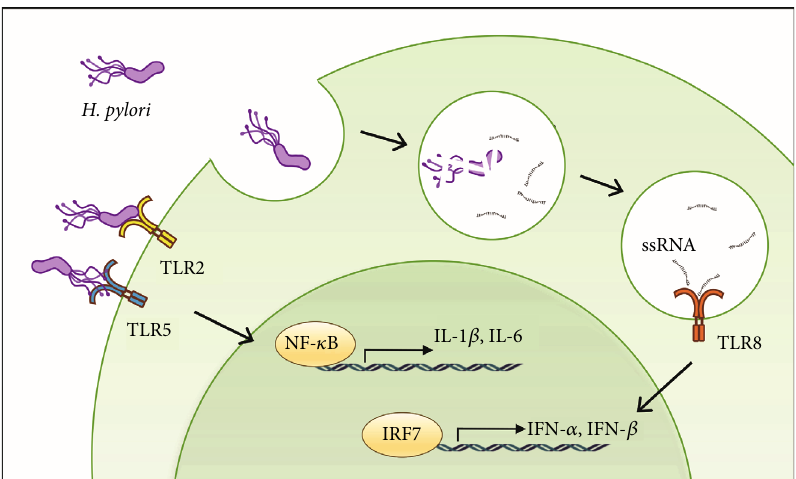
Figure 9: Illustration depicting the detection of H. pylori ssRNA by the endosomal TLR8 and downstream signaling pathway that results in transactivation of IFN- α and IFN - β . In contrast, extracellular bacteria molecules are detected mainly by TLR2 and TLR5 that trigger activation of NF- κ B that transactivates proin fl ammatory cytokines such as IL-1 β and IL-6